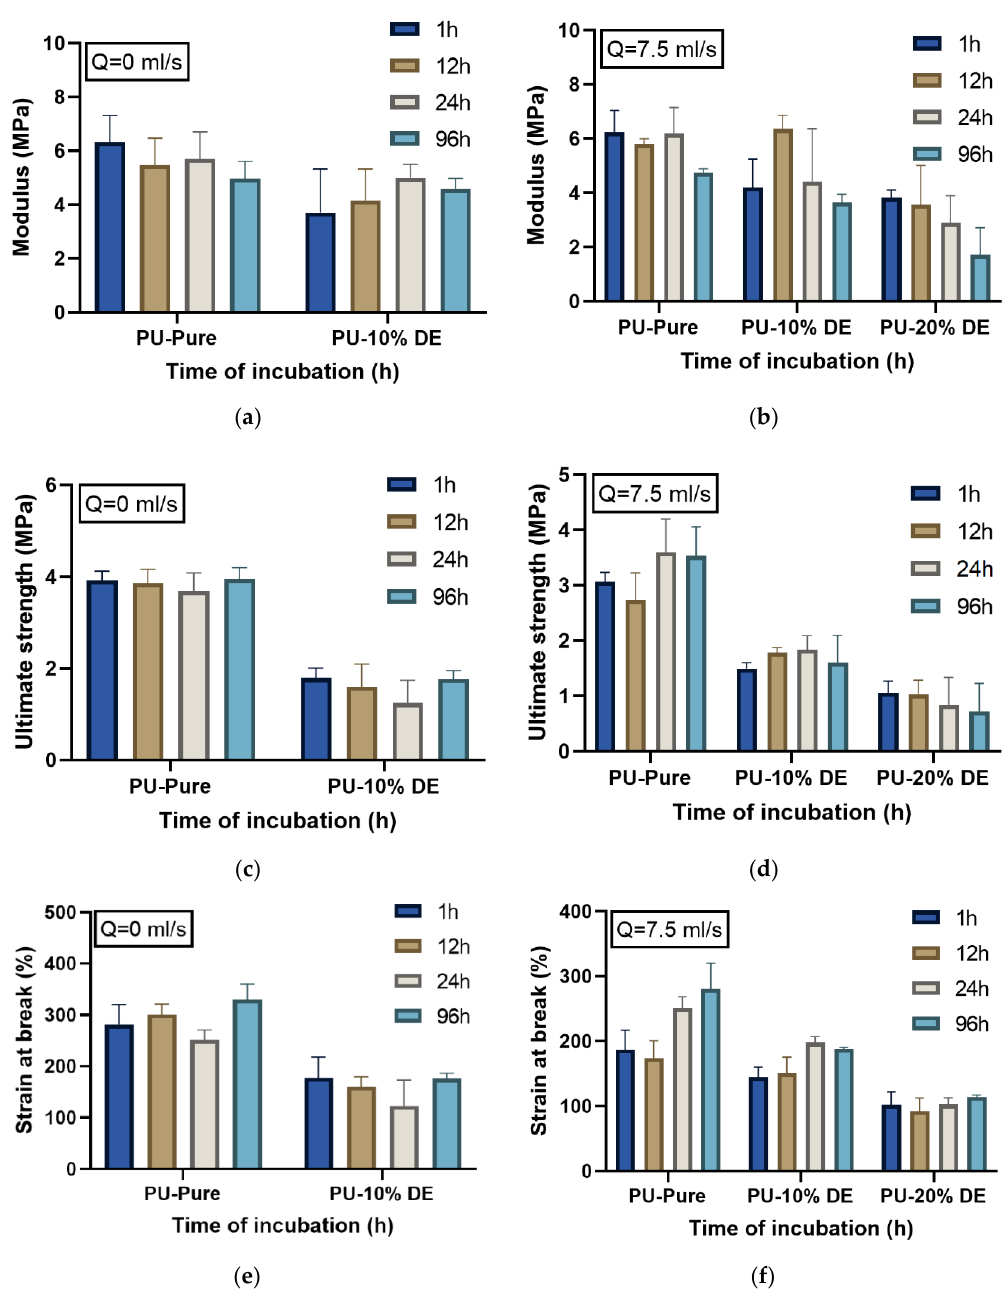
Figure 8. Tensile properties: ( a , b ) modulus, ( c , d ) ultimate strength and ( e , f ) strain at break of PU samples with different percentages of DE after release test in the static and continuous states.